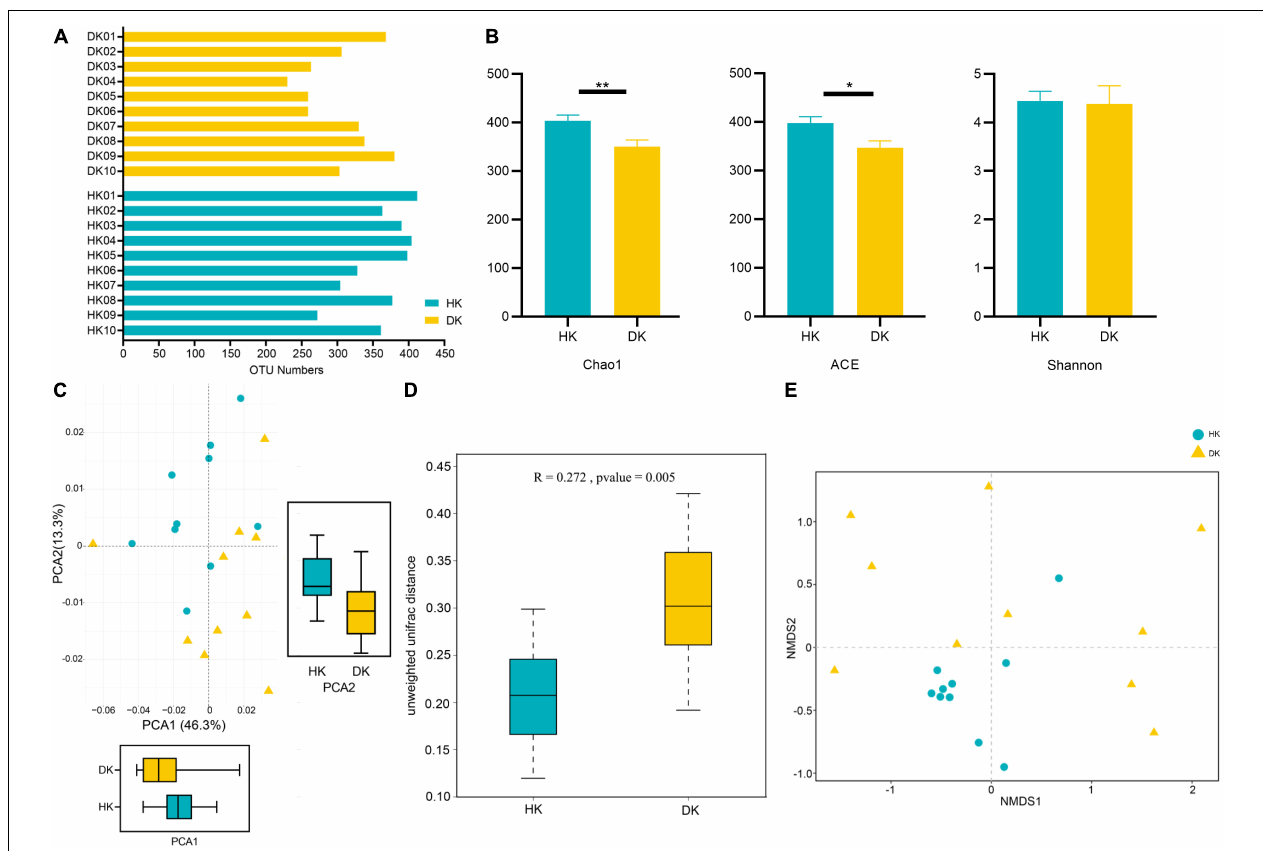
FIGURE 2 | Comparison of fecal microbial community structures between diarrheic and healthy goat kids. (A) OTU numbers in each sample. (B) Alpha diversity analysis, and data represent mean values ± standard error of mean (SEM) n = 10. (C) Principal component analysis (PCA), and sample distance indicates the similarity of composition between the two samples. (D) ANOSIM based on unweighted UniFrac for differences, and the R value indicates the group difference, n = 10. (E) NMDS analysis based on unweighted UniFrac, and the distance between points indicates the degree of sample variation. *Means P < 0.05, **means P < 0.01.